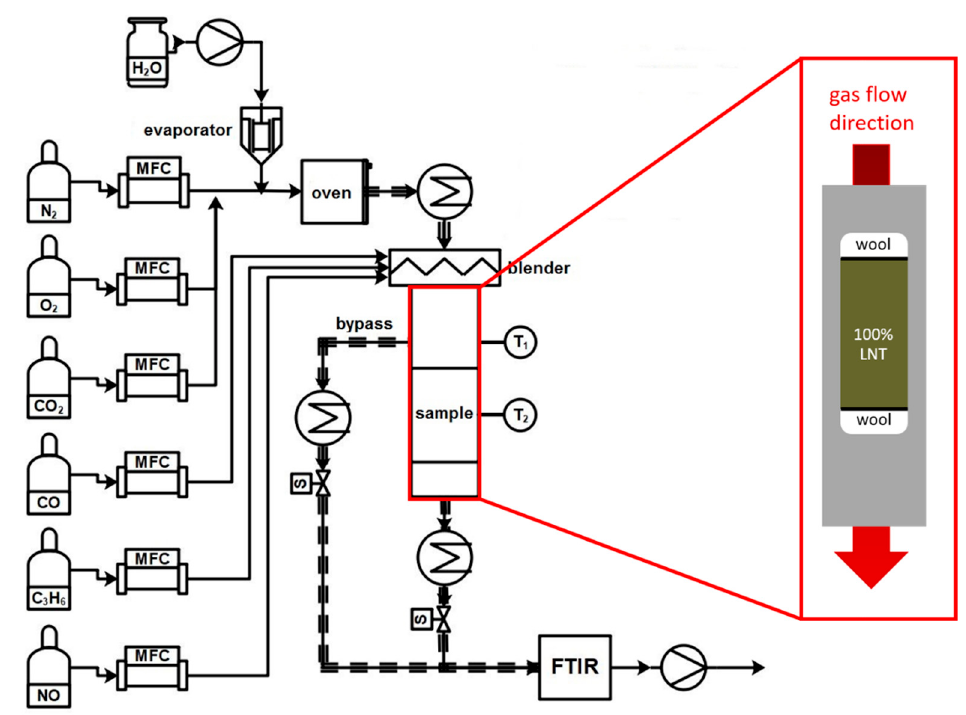
Figure 6. Technical drawing of the test bench and the reactor filling during only LNT catalyst examination experiments.